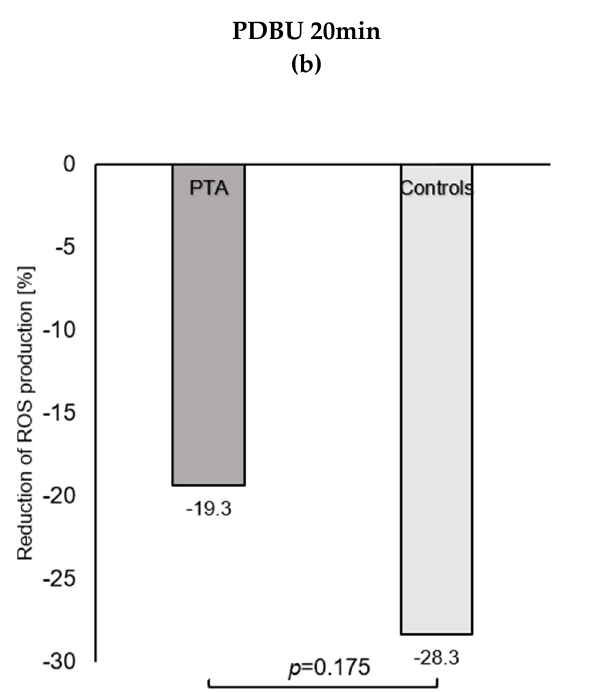
Figure 1. ( a ) Relative reduction in basal whole-blood (leukocyte) ROS production as % of the value at admission in the 2 treatment groups after 3 months. Data are presented as mean values. ( b ) Relative reduction in PDBu-stimulated ROS production as % of the value at admission in the 2 treatment groups after 3 months. Data are presented as mean